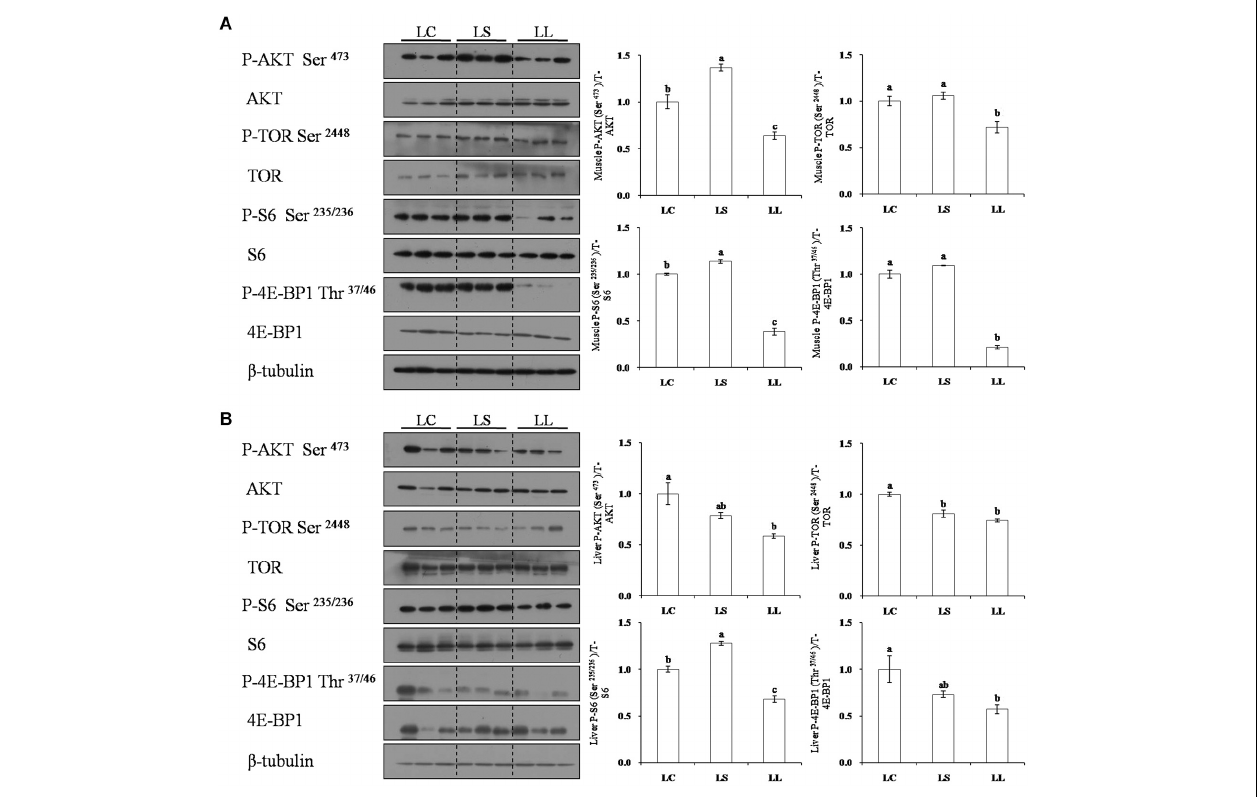
FIGURE 3 | Effects of the LC diet, LL diet supplemented with dietary lysine (LS diet) and the LL diet on muscle (A) and liver (B) protein phosphorylation levels of key regulators involved in TOR signaling pathway. Different superscript letters “a, b, c” indicated statistical significant differences ( P < 0 . 05; mean ± SEM, n =